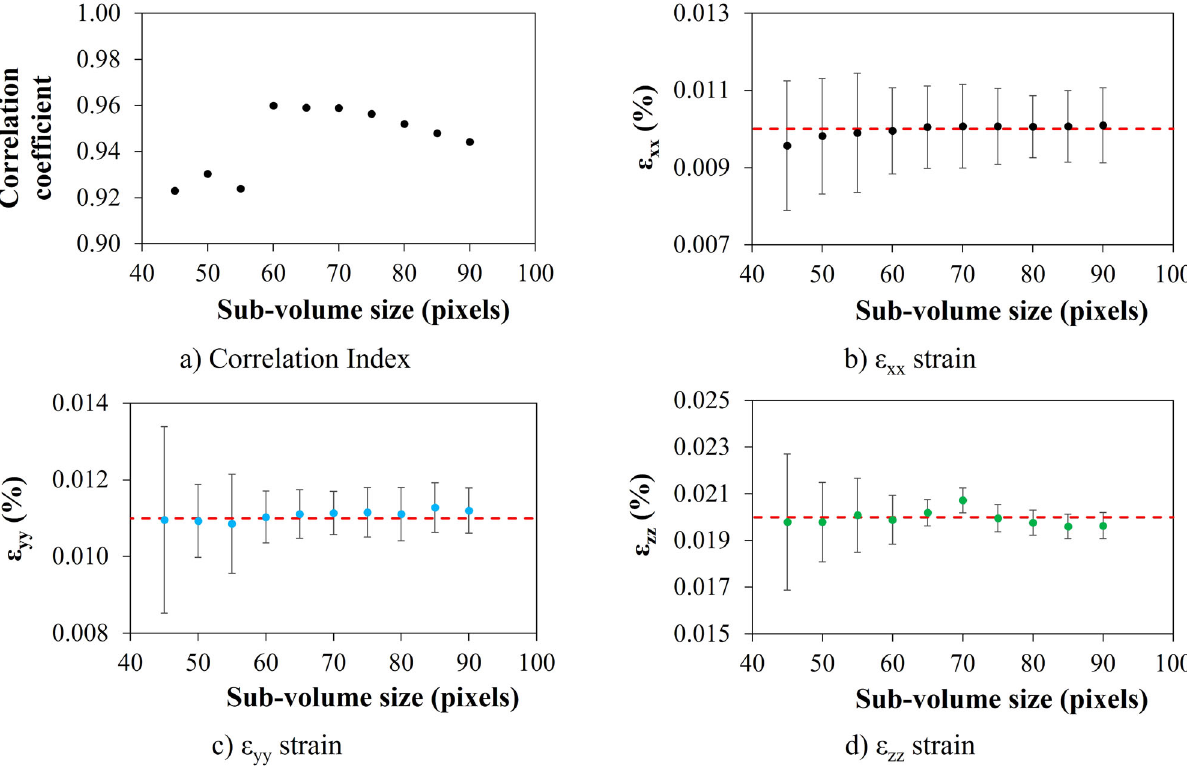
Fig. 6 Sensitivity analysis illustrating the effect of sub-volume size. a The correlation index, b the axial strains ε xx, c the axial strains ε yy, and d the axial strains ε zz, after imposing virtual displacements. Error bars, illustrating the standard deviation, are given for each DVC analysis